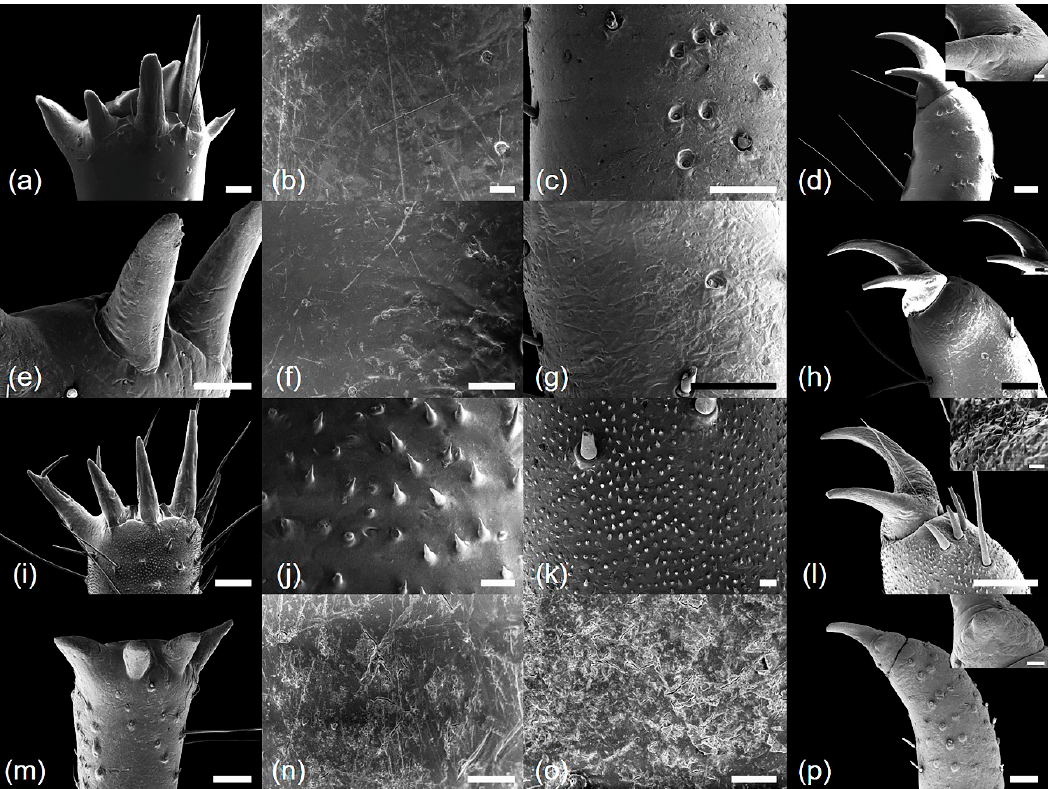
Figure 4. Scanning electron microscope micrographs of four mid-leg parts: ( a – d ) Cryptotympana atrata ; ( e – h ) Hyalessa maculaticollis ; ( i – l ) Meimuna opalifera ; ( m – p ) Platypleura kaempferi ; ( a , e , i , m ) spine of mesotibia; ( b , f , j , n ) surface of mesotibia; ( c , g , k , o ) surface of mesotarsus; ( d , h , l , p ) apex of mesotarsus. Inset micrographs show a surface pattern between their mesotarsal claws. All scale bars = 200 μ m (except b , f , j , k , n , o , scale bars = 20 μ m; inset d , h , l , and p , scale bars = 40, 200, 10, and 40 μ m, respectively).